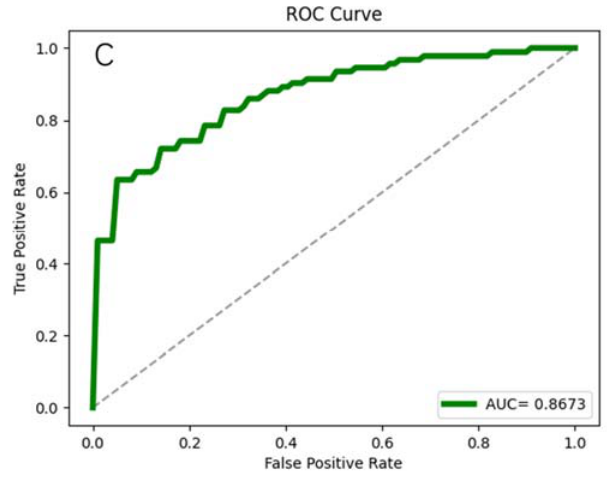
Figure 4. ROC and corresponding AUC of each prediction model on the validation set. where ( A – C ) Figure 4. ROCandcorrespondingAUCofeachpredictionmodelonthevalidationset. where( A – C ) represent represent the results of ResNet ‐ 34, ResNet ‐ 18, VGG ‐ 16, respectively. the results of ResNet-34, ResNet-18, VGG-16, respectively. Table 3. The performance of different prediction models on the validation set. Model Acc Recall Prec F 1 Score ResNet-34 0.8827 ± 0.0562 0.8281 ± 0.0703 0.9058 ± 0.0699 0.8644 ± 0.0663 ResNet-18 0.8432 ± 0.0216 0.7304 ± 0.0344 0.9063 ± 0.0293 0.8086 ± 0.0306 VGG-16 0.8043 ±